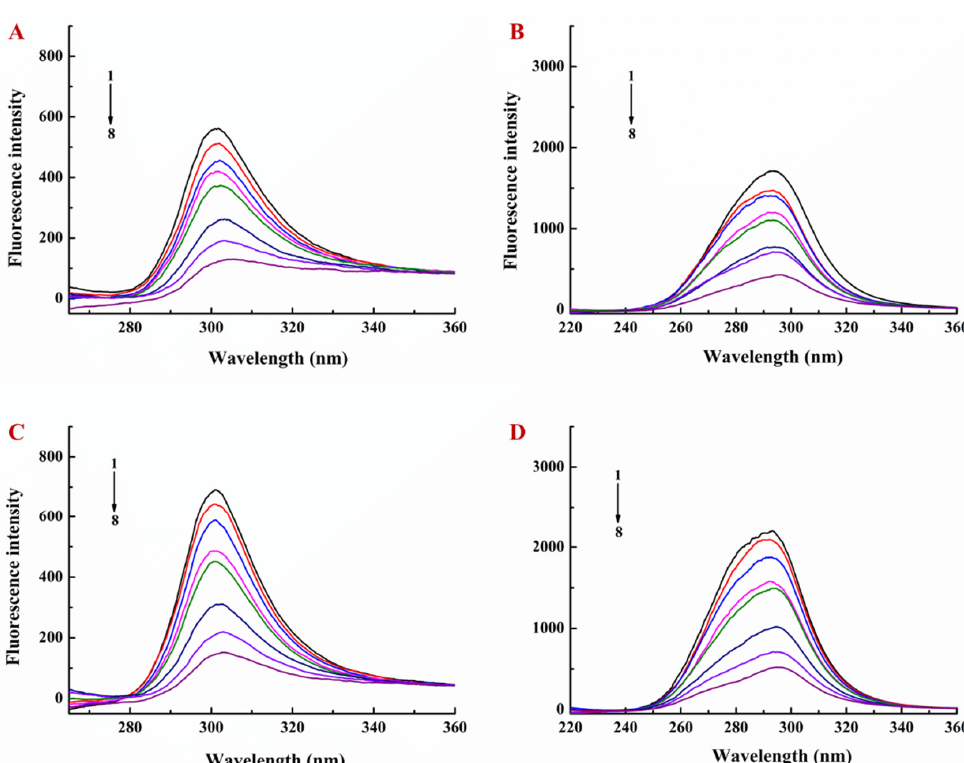
Figure 4. Effect of EGCG on synchronous fluorescence spectra of lysozyme/pectin nanoparticles at 25 °C with lysozyme/pectin mass ratio of 1:1, ( A ) Δλ = 15 nm and ( B ) Δλ = 60 nm, and with lysozyme/pectin mass ratio of 1:2, ( C ) Δλ = 15 nm and ( D ) Δλ = 60 nm.